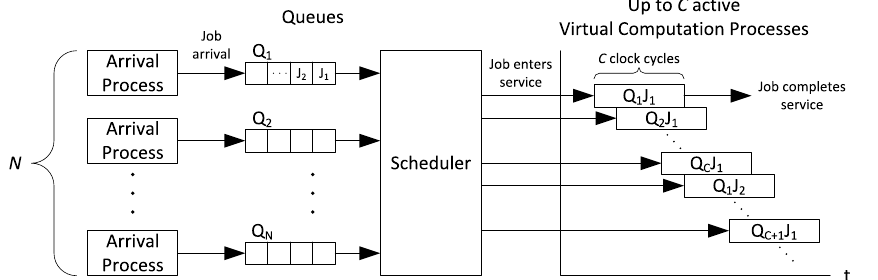
Figure 8. Discrete-event simulation system of virtualized hardware design. The server, composed of the scheduler and virtual computation processes, is discrete-time, cycle-accurate. The scheduler implemented is hierarchical